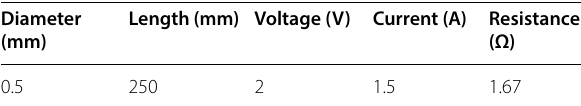
Table 2 Parameters of the Ni‑Ti